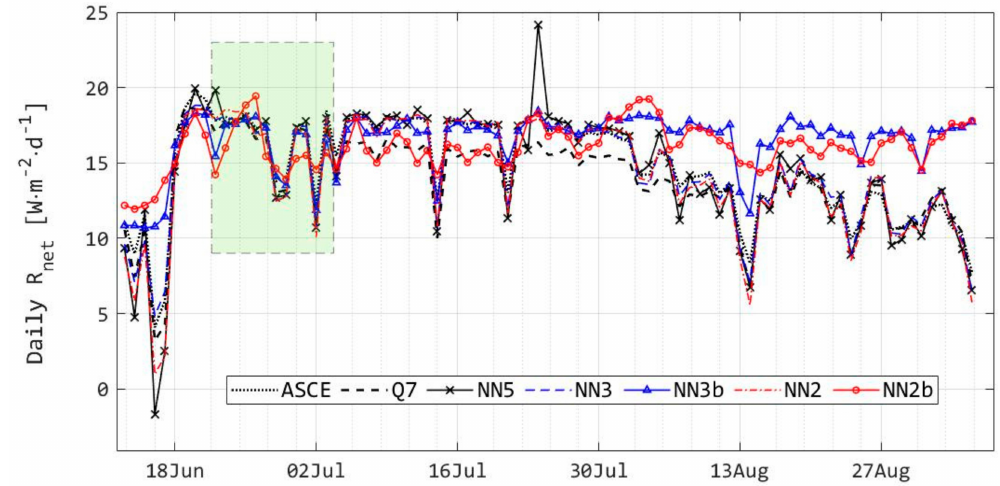
Figure 9. Daily net radiation measured by Q-7 sensor, modelled by five NN, and calculated by ASCE / FAO56 method. Period of record used for training models is indicated by shaded box.